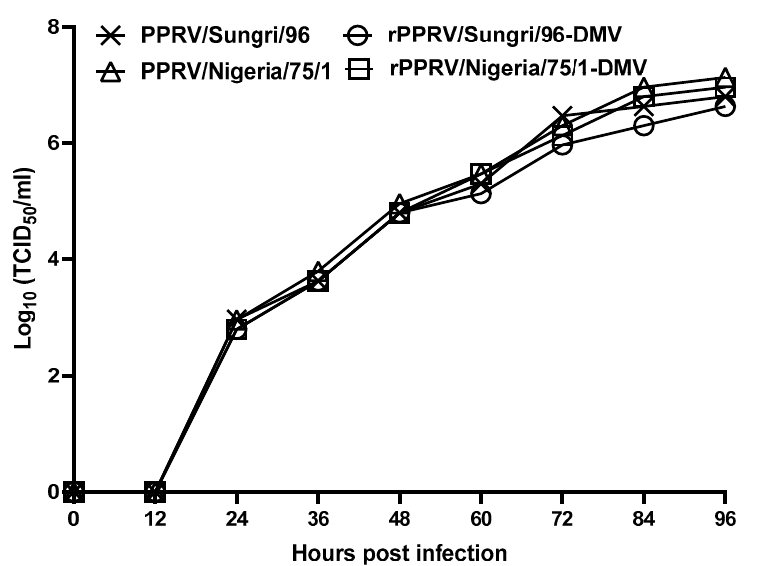
Figure 2. Growth of the recombinant DIVA viruses in cell culture. Growth rates of the recombinant viruses were determined under multi-step growth conditions (MOI = 0.01) for the parental PPRV and two DIVA viruses in the VDS cells.